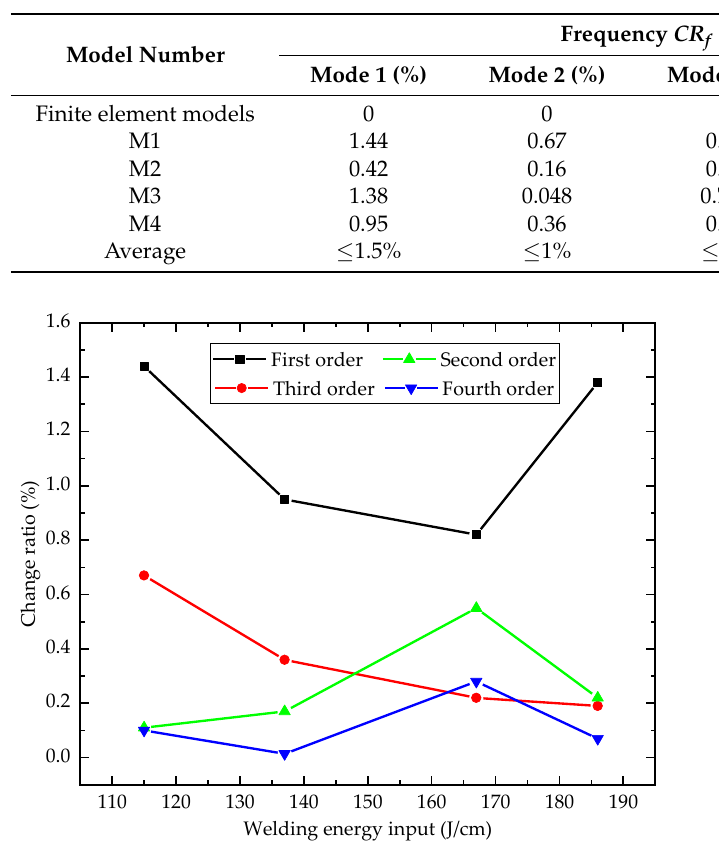
Figure 9. Influence of welding energy input on the natural frequency.